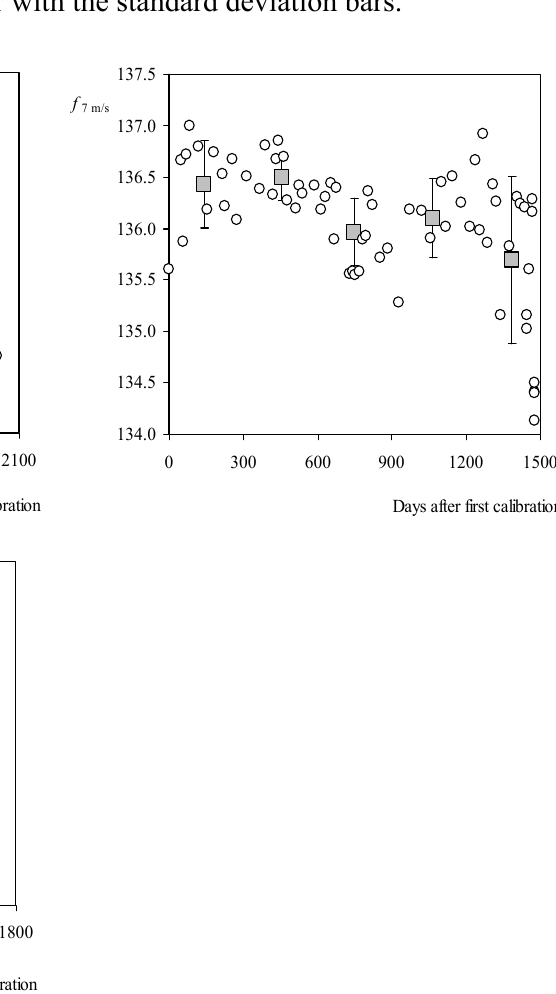
Figure 2. Variation of the output frequency at 7 m·s − 1 wind speed, f the number of days after the first calibration, for the IDR/UPM Institute’s anemometers, Cl-100075 (top left side), A100 L2 (top right side), and Th-4.3350 (bottom). The 300-day average value has been included, together with the standard deviation